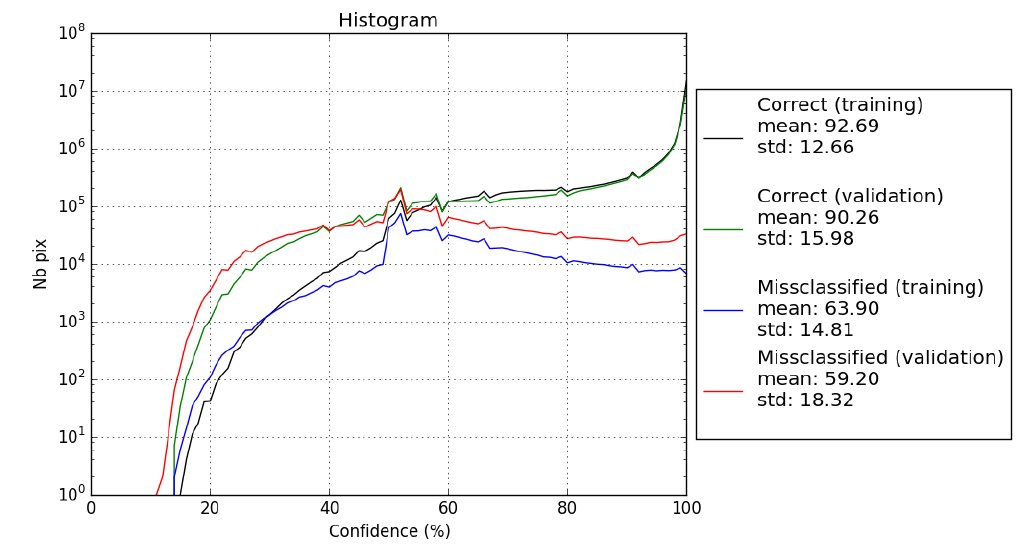
Figure 18. Confidence